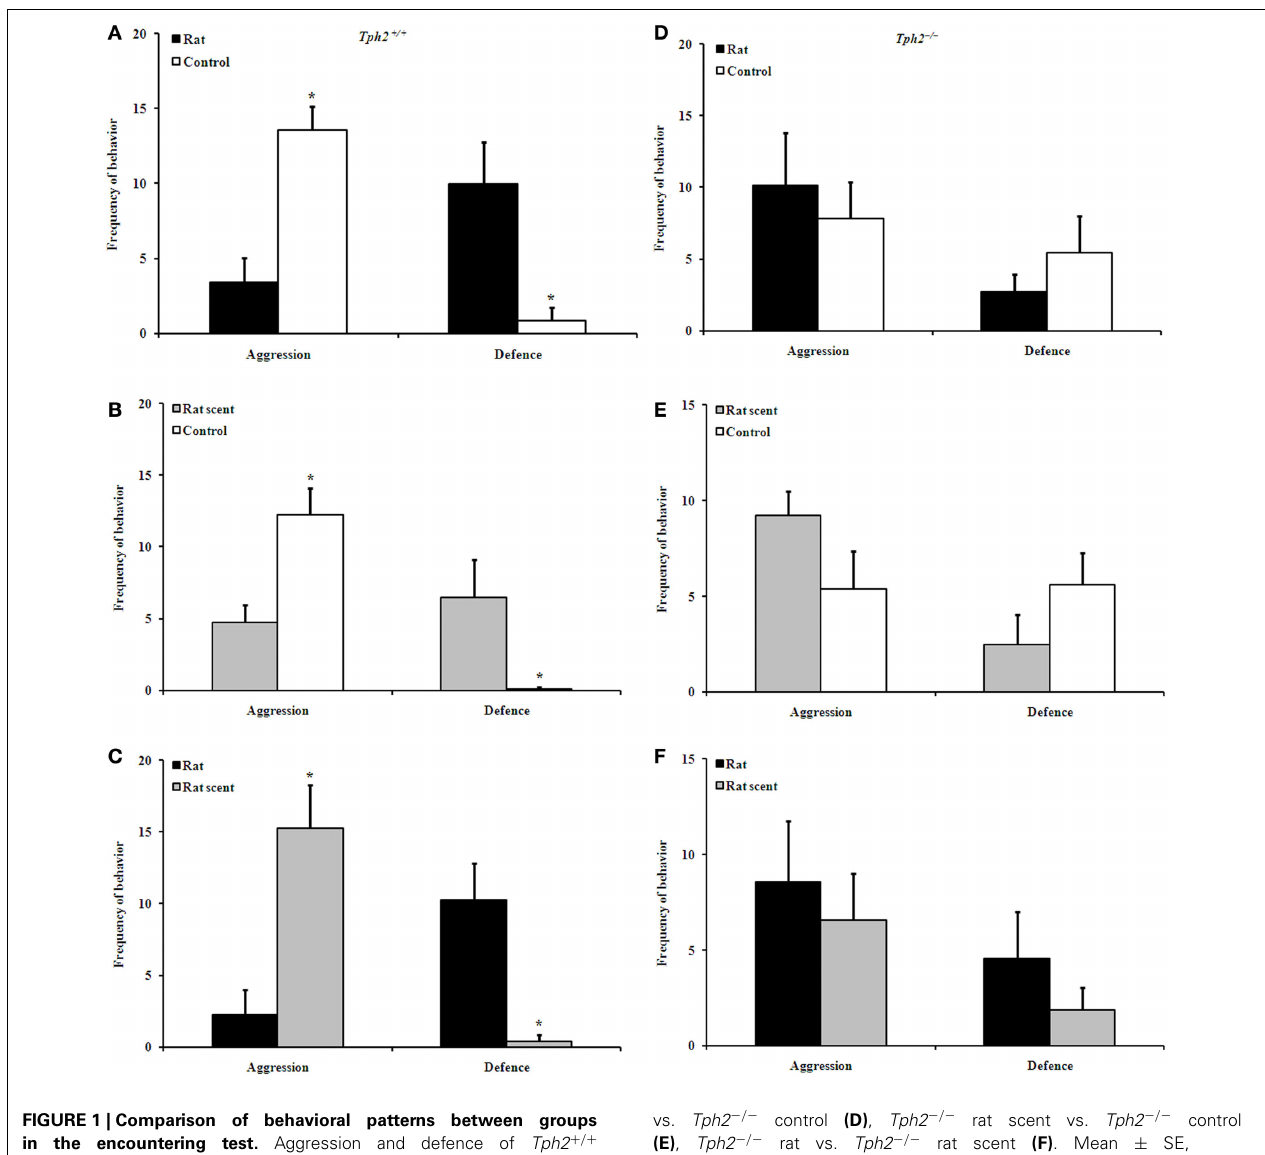
vs. Tph2 − / − control (D) , Tph2 − / − rat scent vs. Tph2 − / − control (E) , Tph2 − / − rat vs. Tph2 − / − rat scent (F) . Mean ± SE, n Rat = 7, n Ratscent = 8, n Control = 8, ∗ p < 0 . 05, Wilcoxon matched-pairs signed-rank test.